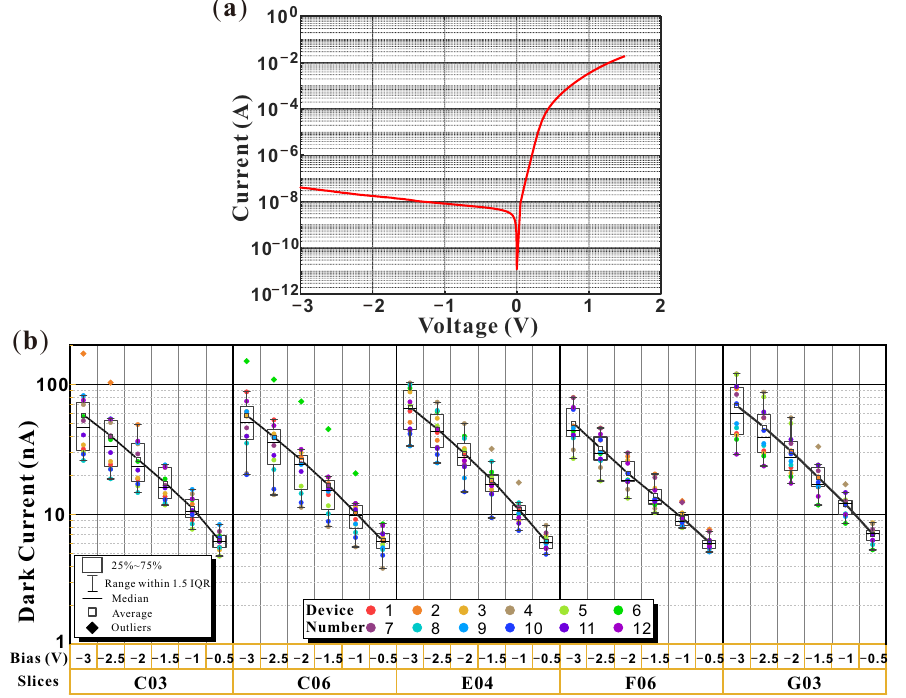
Figure 5. ( a ) I–V curve of the photodetector plotted on a logarithmic scale for the y-axis. The dark current at − 1 V and − 3 V is around 10 nA and 50 nA, respectively. ( b ) The boxplot of the dark currents of 60 identical devices at different biases are presented, where the devices were fabricated on 5 different slices labeled as C03, C06, E04, F06, and G03. Each slice contained 12 devices, represented by different colors in the